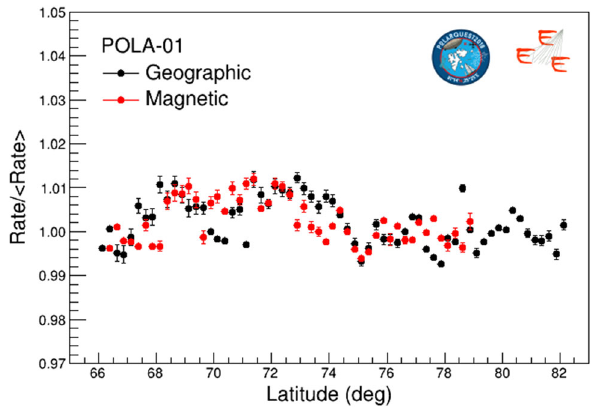
Fig. 31 Rate measured by POLA-01, divided by the average rate, as a function of geographic (black points) and geomagnetic (red points) latitude, once all corrections have been applied. All data points fall within a ± 1% band around the